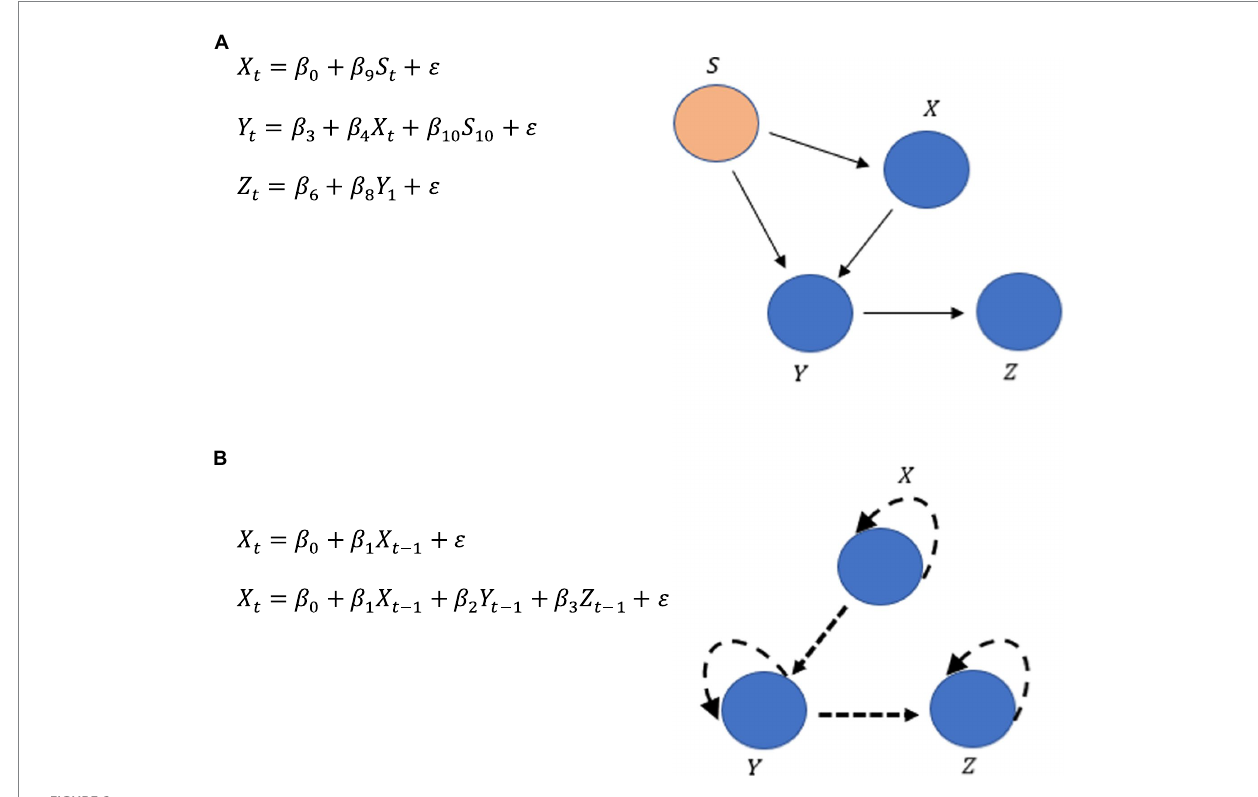
FIGURE 6 (A) Typical SEM pathways. (B) An illustration of the vector autoregressive updating in a time series ideographic